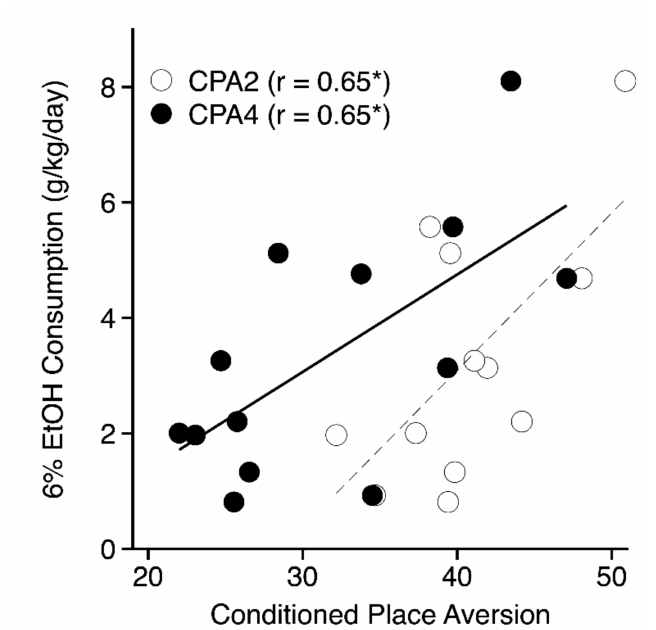
Figure 6. Scatterplot depicting the genetic correlations between mean 6% ethanol consumption [5] (y-axis) and conditioned place aversion indexed as mean percent time on the ethanol-paired floor (x-axis) for the 2- (open symbols, dashed line) and 4- (closed symbols, solid line) g / kg groups. Each point represents the strain mean scores for both phenotypes.